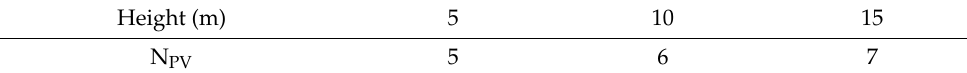
Table 11. Changes in the number of PV arrays relative to water extraction height.